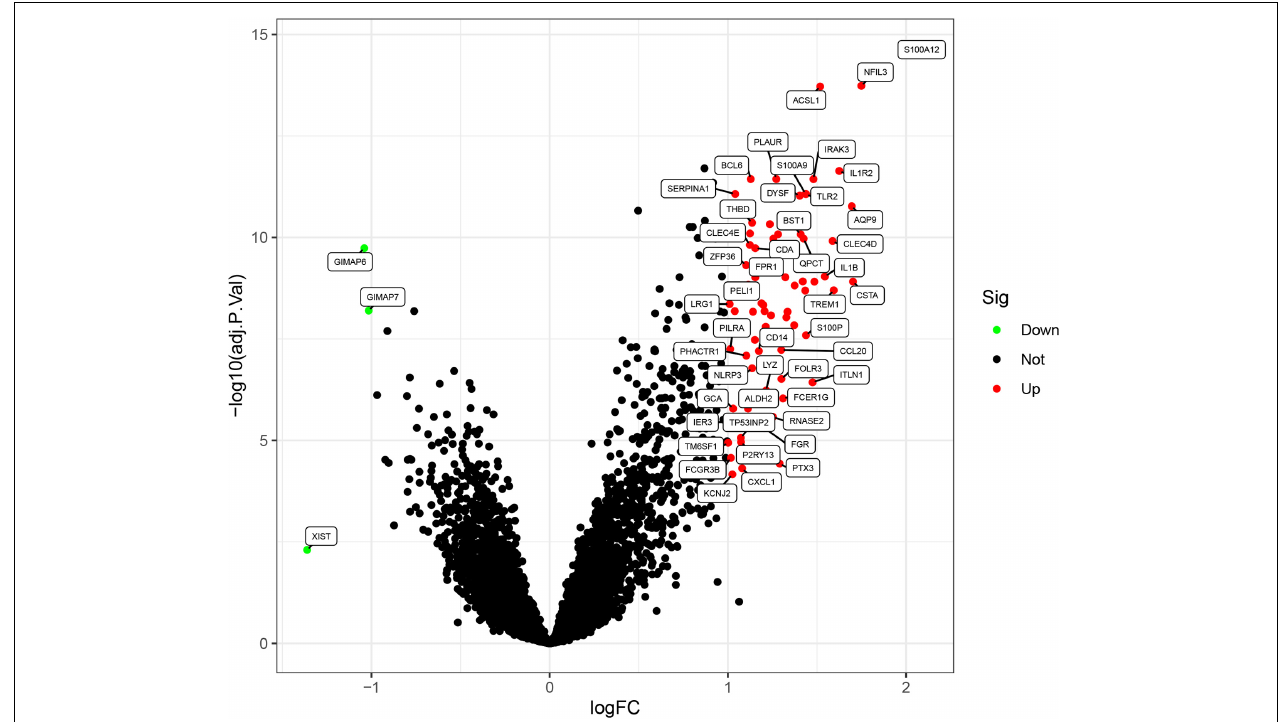
FIGURE 1 | Differentially expressed genes (DEGs) between acute myocardial infarction samples and control ones. The red dots represent upregulated differential genes, the green dots represent differential downregulated genes, and the black dots represent genes without significant differences.